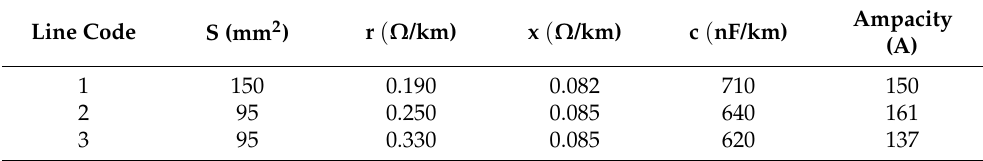
Figure 7. The RTDS low-voltage network.